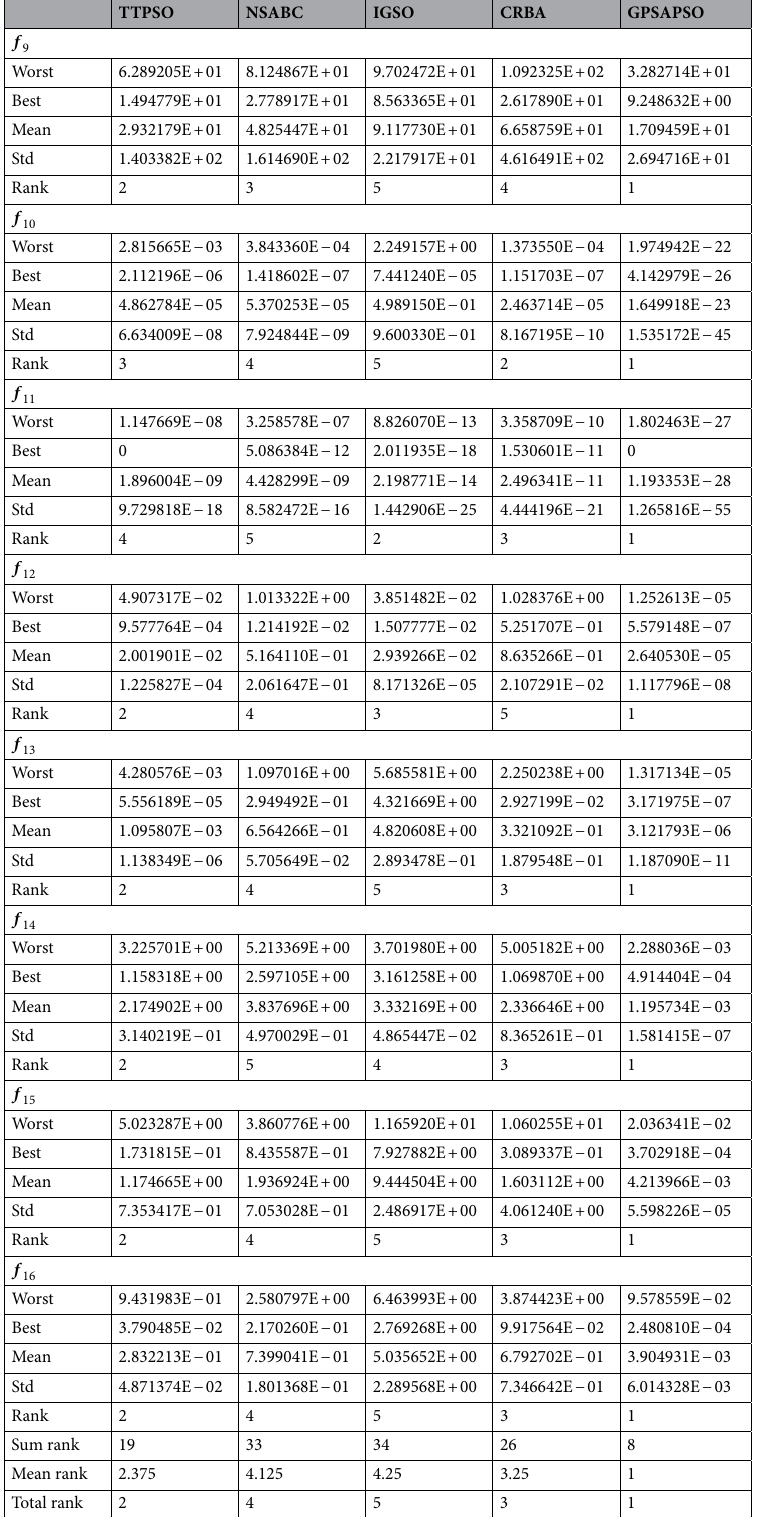
Table 4. Results of 30 times of high-dimensional function